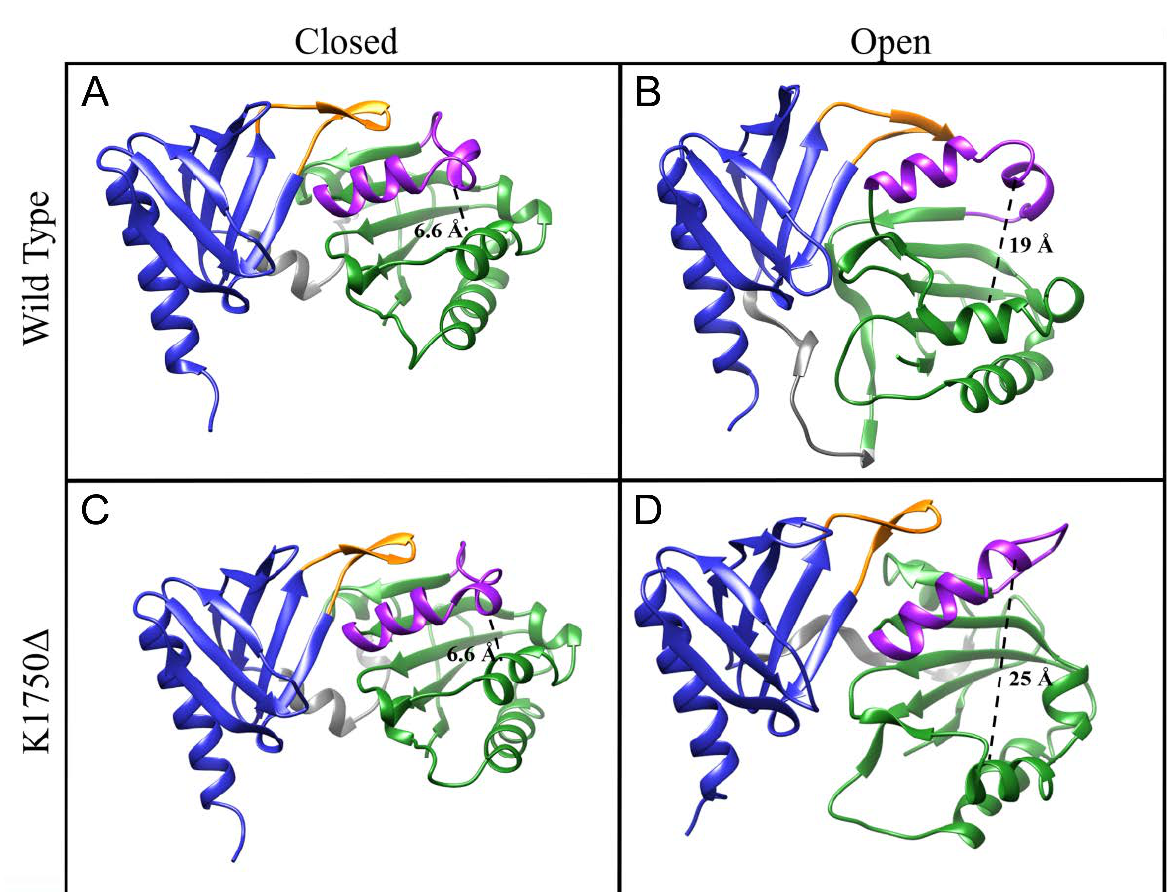
Figure 4. Comparison of the closed and open conformation for the Sec14 domain of neurofibromin. The distance between the α -carbons of S1639 and L1675 is shown with a dashed line. Those frames were chosen from trajectories at 400 K for wt ( A , B ) or K1750Δ ( C , D ) in which two conditions were